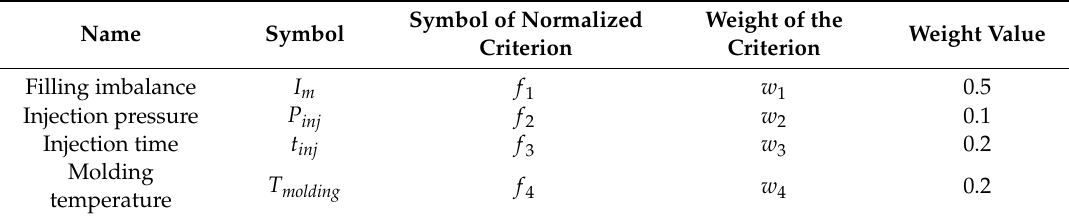
Table 2. Optimization criteria.